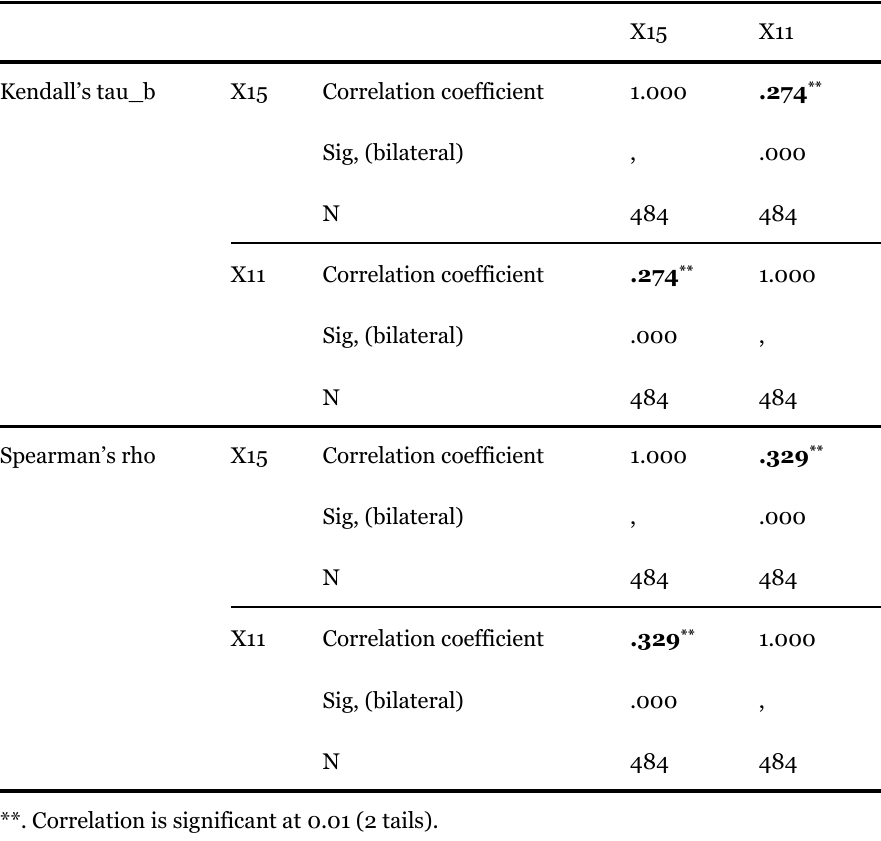
Kendall’s and Spearman’s Correlation Coefficients for X11 (Level of Education) and X15 (Participation in Online